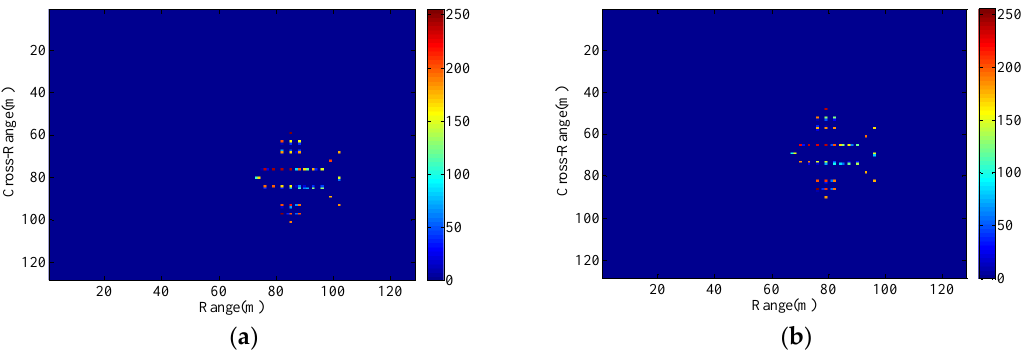
Figure 15. Imaging results with the radar platform vibration parameters P11. ( a ) P12; ( b ) P13.